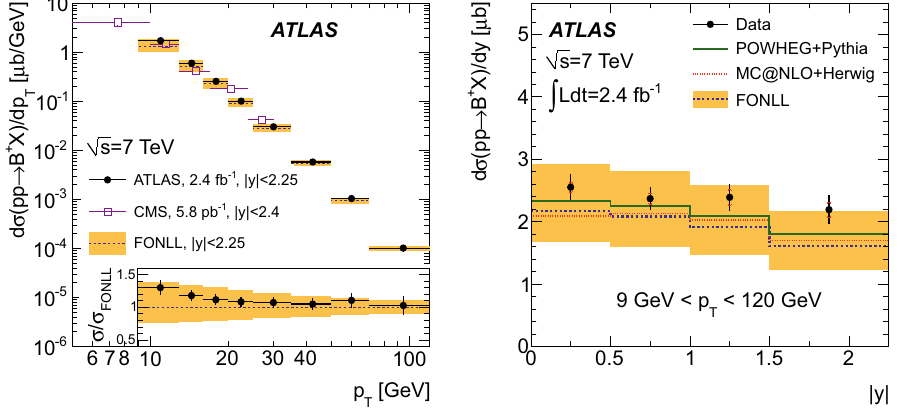
Figure 2. (a) Di ff erential cross-section of B + production vs p T , integrated over rapidity [3]. The solid circle points with error bars correspond to the di ff erential cross-section measurement of ATLAS with total uncertainty (statistical and systematic) in the rapidity range | y | < 2 . 25, averaged over each p T interval and quoted at its centre. For comparison, data points from CMS are also shown, for a measurement covering p T < 30 GeV and | y | < 2 . 4. Predictions of the FONLL calculation for b -quark production are also compared with the data, assuming a hadronisation fraction of f ¯ b → B + of (40 . 1 ± 0 . 8)% to fix the overall scale. Also shown is the ratio of the measured cross-section to the predictions of the FONLL calculation ( σ/σ FONLL ). The upper and lower uncertainty limits on the prediction were obtained considering scale and b -quark mass variations. (b) Di ff erential cross-section of ff erential cross-section B + production vs rapidity, integrated over p T . Points with error bars correspond to the di measurement with total uncertainty (lines on the error bars indicate the statistical component) in the p T range 9 GeV < p T < 120 GeV, averaged over each rapidity interval and quoted at its centre. P owheg , MC@NLO and FONLL predictions are also given for comparison. The relevant uncertainties of the predictions of P owheg and MC@NLO are of the same order as for FONLL and are not